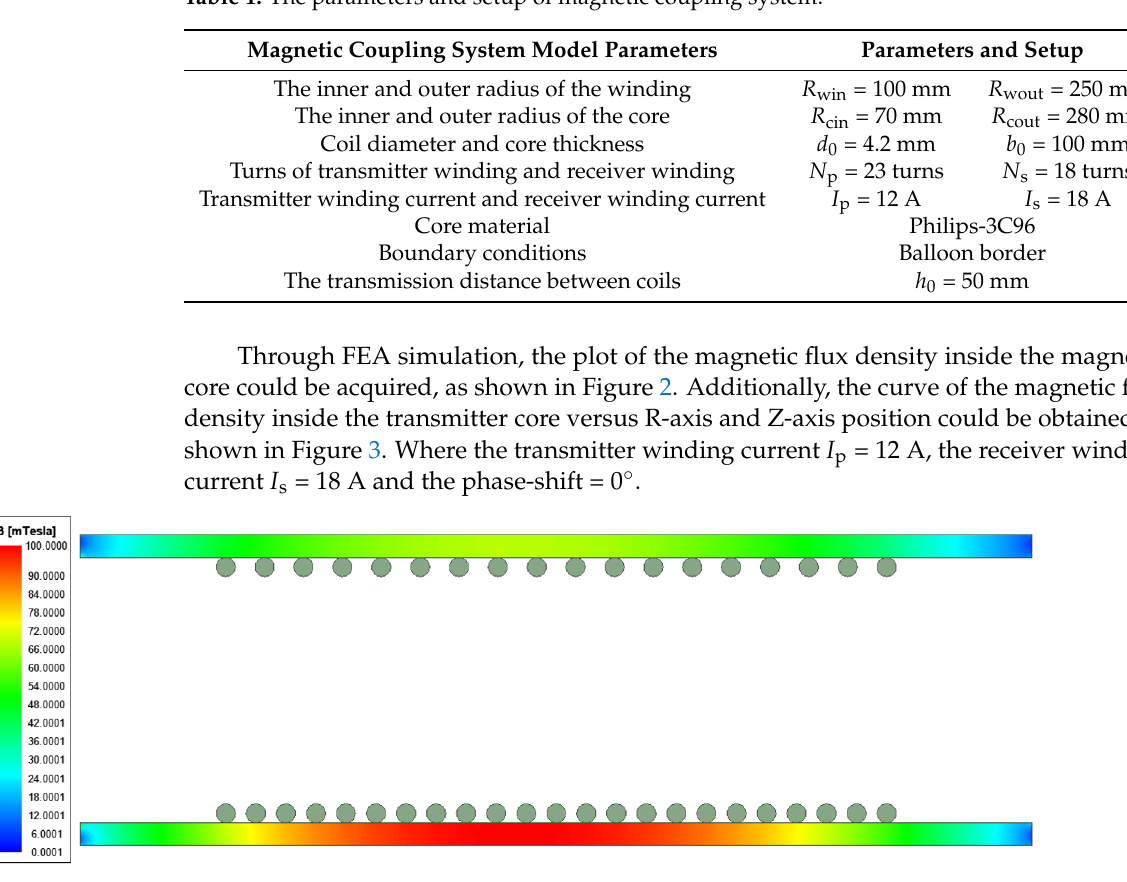
Figure 2. The distribution of magnetic flux density inside the transmitter core and the receiver core.